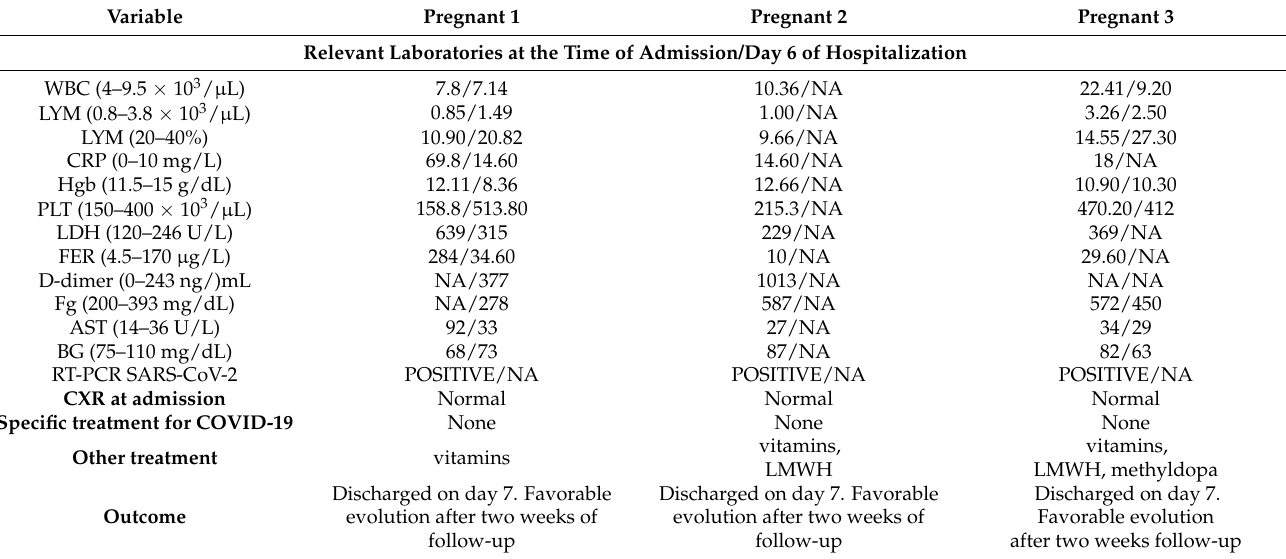
Table 2. Available relevant laboratory data, treatment, and outcome at